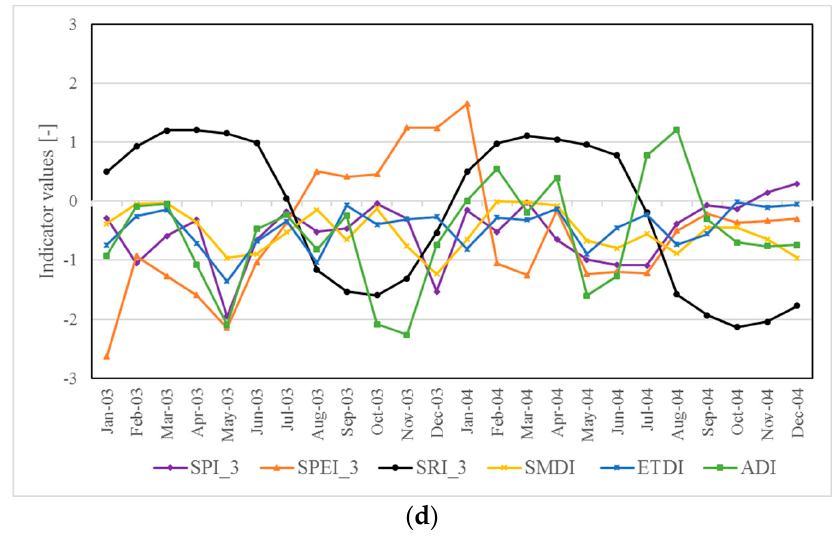
Figure 6. The time series plot of the six drought indices for 1973/1978 ( a ), 1983/1984 ( b ), 1989/1994 ( c ), and 2003/2004 ( d ) historic drought years in the UBN basin.